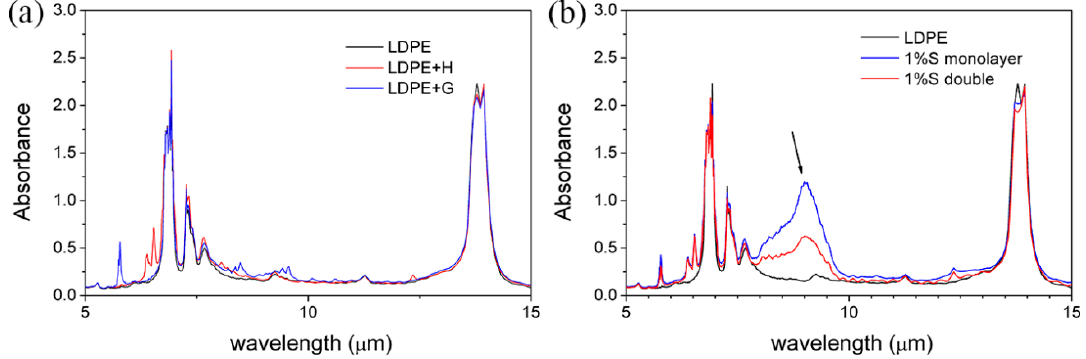
Figure 7. ( a ) An absorption spectrum of LDPE, LDPE + H, and LDPE + G; ( b ) An absorption spectrum of LDPE, 1%S monolayer, and 1%S double.